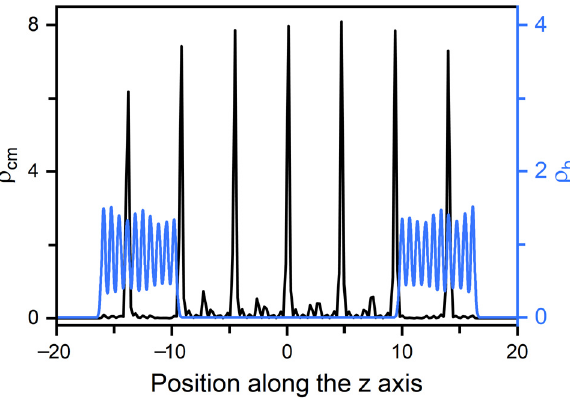
Figure 5. Density distributions for the center of mass of mesogens and the beads of amphiphile tails in a typical homeotropic smectic anchoring at T = 0.3 and ρ s = 0.6. The corresponding bead density distributions are presented in Figure S1.